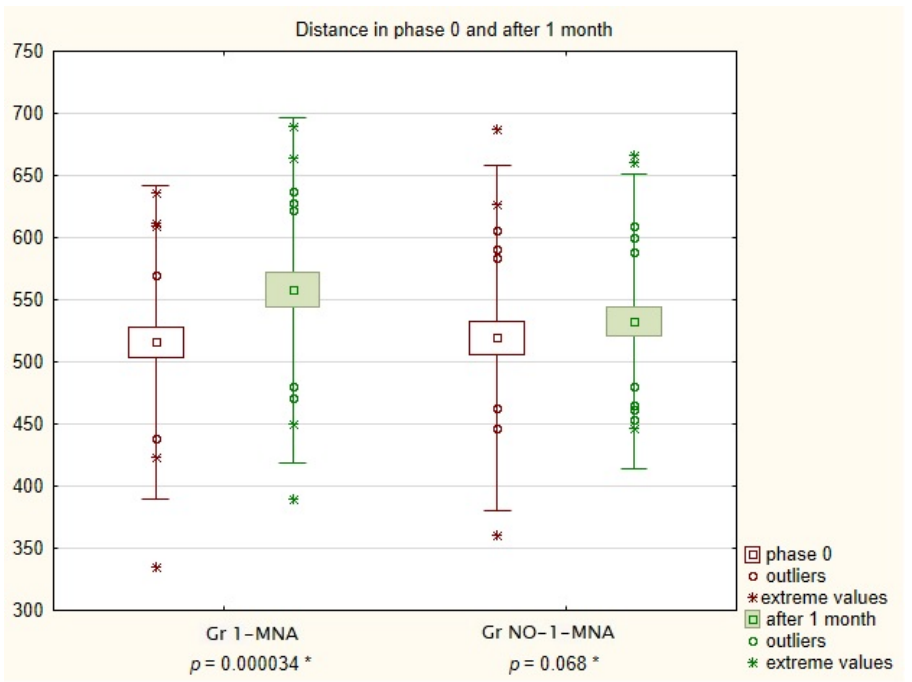
Figure 2. Mean distance for Groups NO-1-MNA and 1-MNA in 6MWT after 1 month of supplementation with 1-MNA. Gr NO-1-MNA—patients without supplementation; Gr 1-MNA—patients with 1-MNA supplementation; 6MWT—6-min walk test. * the Wilcoxon pairs test. In Gr 1-MNA, significantly more pts improved their distance in the 6MWT (23 out of 25 pts, equal to 92%), by a mean of 47 m, compared with Gr NO-1-MNA (15 of 25 pts,